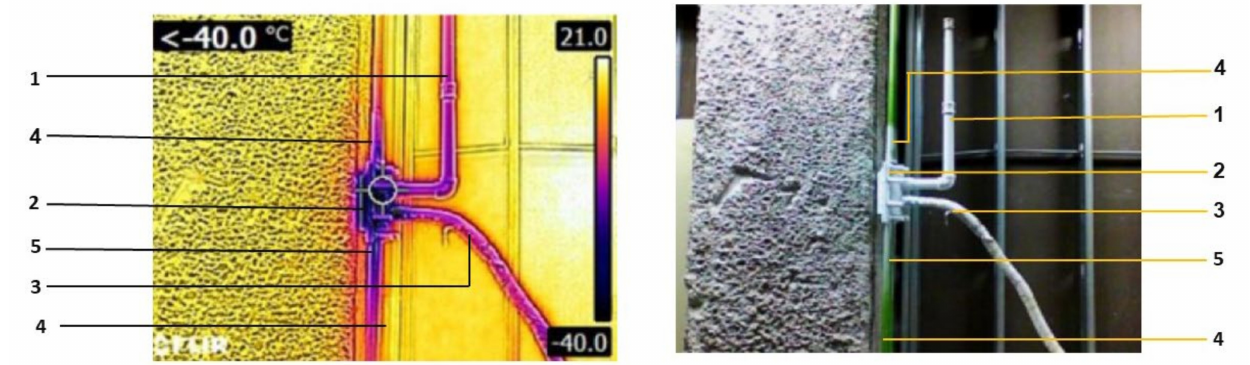
Figure 7. Infrared thermal imaging and onsite freezing jacket.